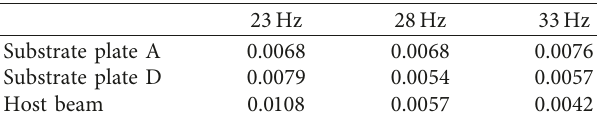
Table 7: Averaged displacement (m) of the nonlinear EMM system in 100 seconds.